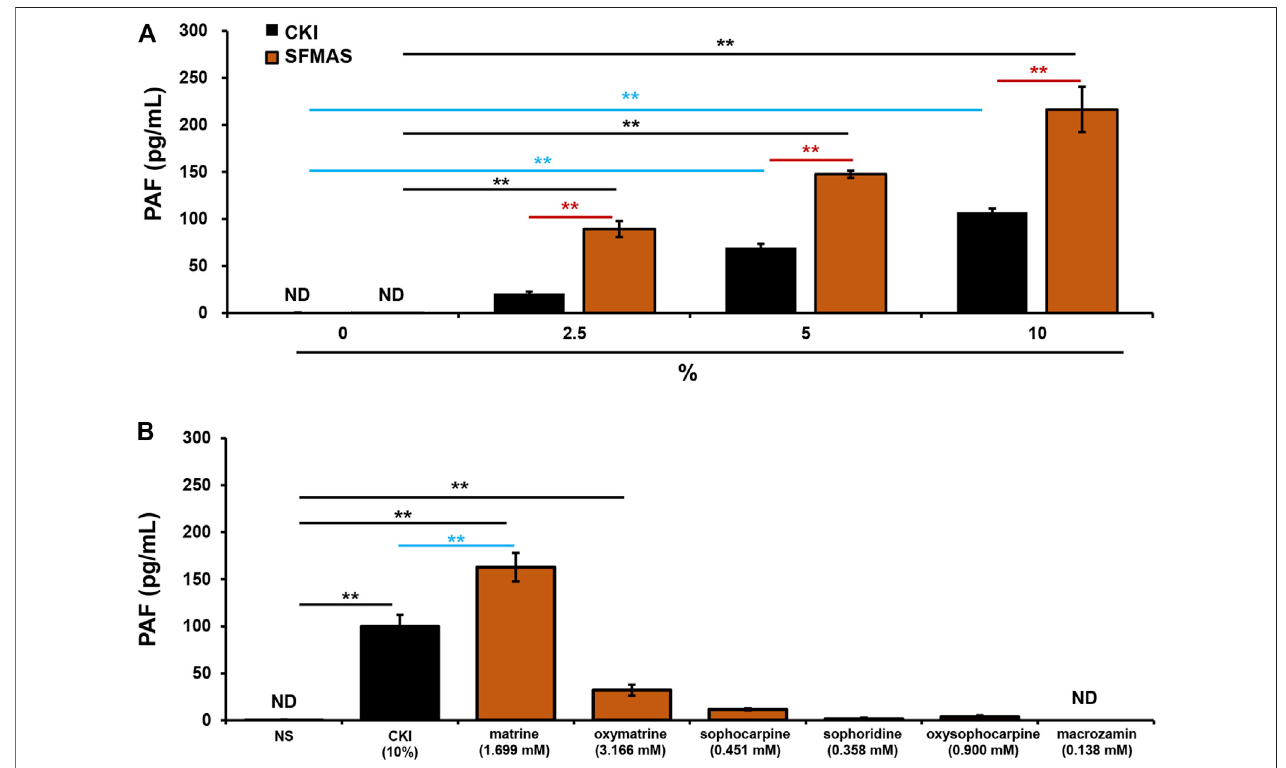
FIGURE 7 | SF-alkaloids are responsible for CKI-induced NIN-IHRs. (A) Effects of CKI and SFMAS on PAF production in RBL-2H3 cells. RBL-2H3 cells were incubatedwithCKIorSFMASat37 ° Cfor1 h.Thecellculturesupernatantwascollectedandcentrifuged(1,000 × g)at4 ° Cfor20 min.ThesupernatantwasusedforPAF assaybyusingcommercialPAFELISAkit. ** p < 0.01. (B) Effects ofsixquanti fi edconstituents inSFonPAFproduction inRBL-2H3 cells.RBL-2H3cellswereincubated with different constituents (1.699 mM matrine, 3.166 mM oxymatrine, 0.451 mM sophocarpine, 0.358 mM sophoridine, 0.900 mM oxysophocarpine, 0.138 mM macrozamin) at37 ° Cfor1 h. Thecell culture supernatant wascollectedand centrifuged(1,000 × g) at4 ° Cfor20 min. Thesupernatant wasused for PAFassaybyusing commercial PAF ELISA kit. ** p < 0.01. CKI, Compound Kushen Injection; ND, not detected; NIN-IHRs, non-immunologic immediate hypersensitivity reactions; NS, normal saline; PAF, platelet-activating factor; SFMAS, Sophora fl avescens Ait. main alkaloids solution.